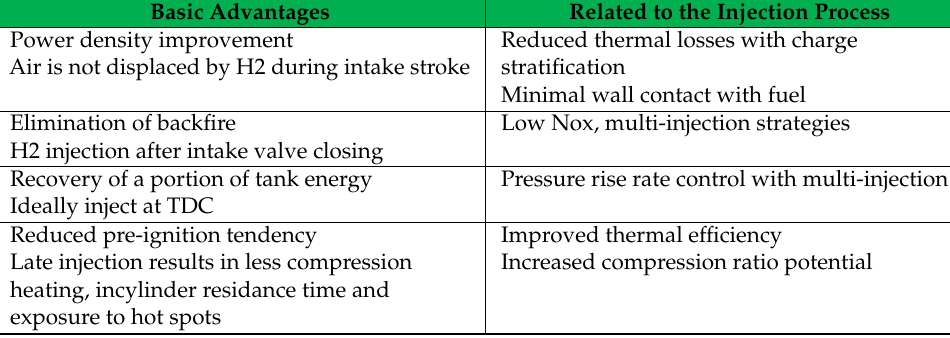
Table 4. Advantages of direct injection vs. port fuel injection